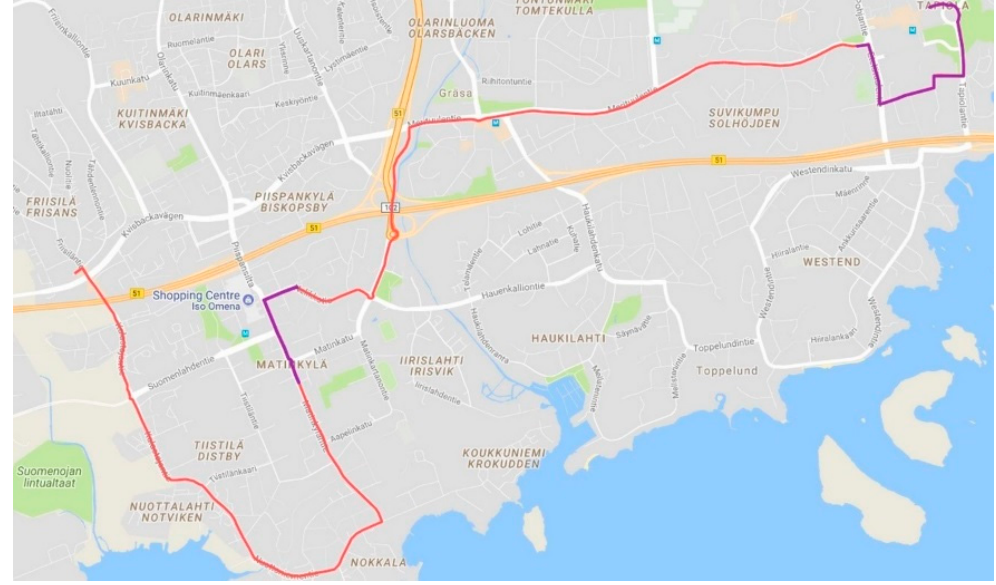
Figure 3. Espoo bus line 11, purple sections indicate areas with high density urban dwellings. (Map data ©2018 Google).